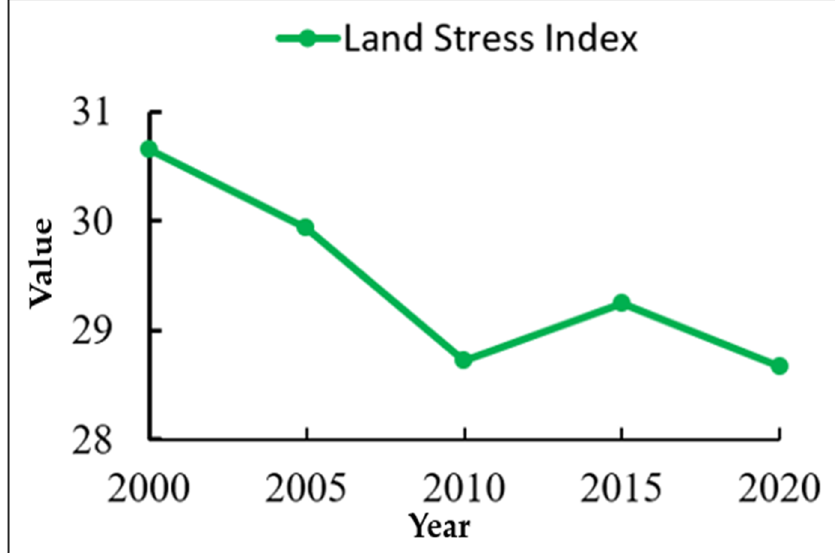
Figure 13. The change of land stress index in Rangtang County.